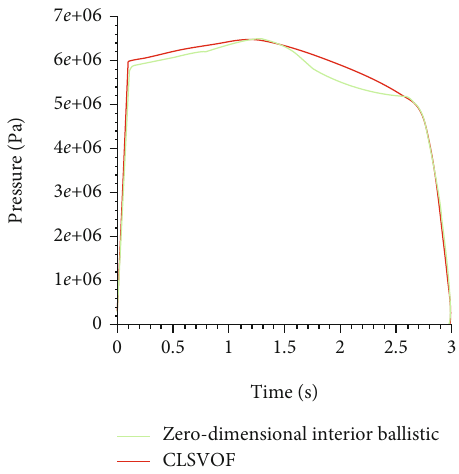
Figure 8: Comparison of combustion chamber